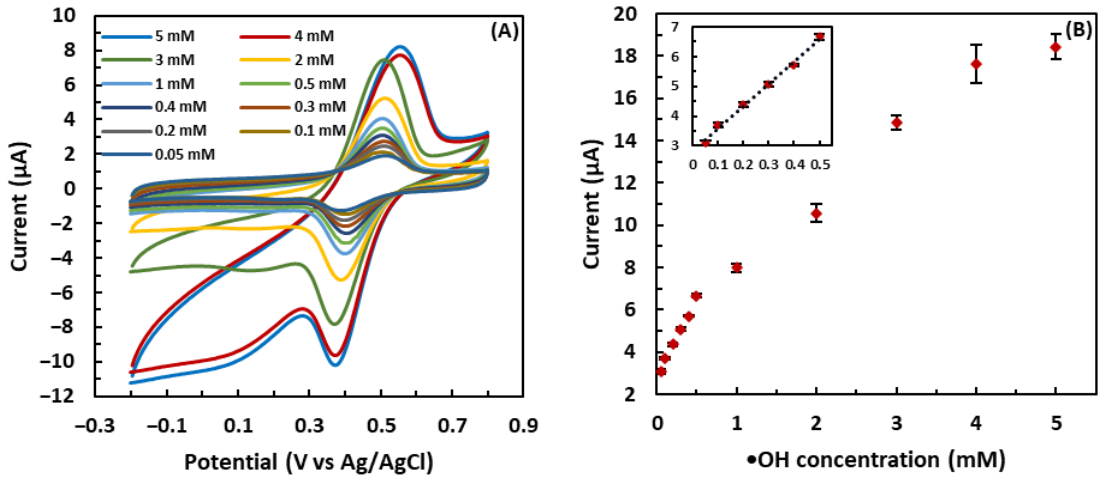
Figure 6. ( A ) Cyclic voltammograms of the GSH-modified electrode for • OH with different concen- trations from 0.05 mM to 5 mM. ( B ) Relationship of the redox response ( ∆ A) with • OH concentration. The error bars indicate the standard deviation of three repetitive experiments.